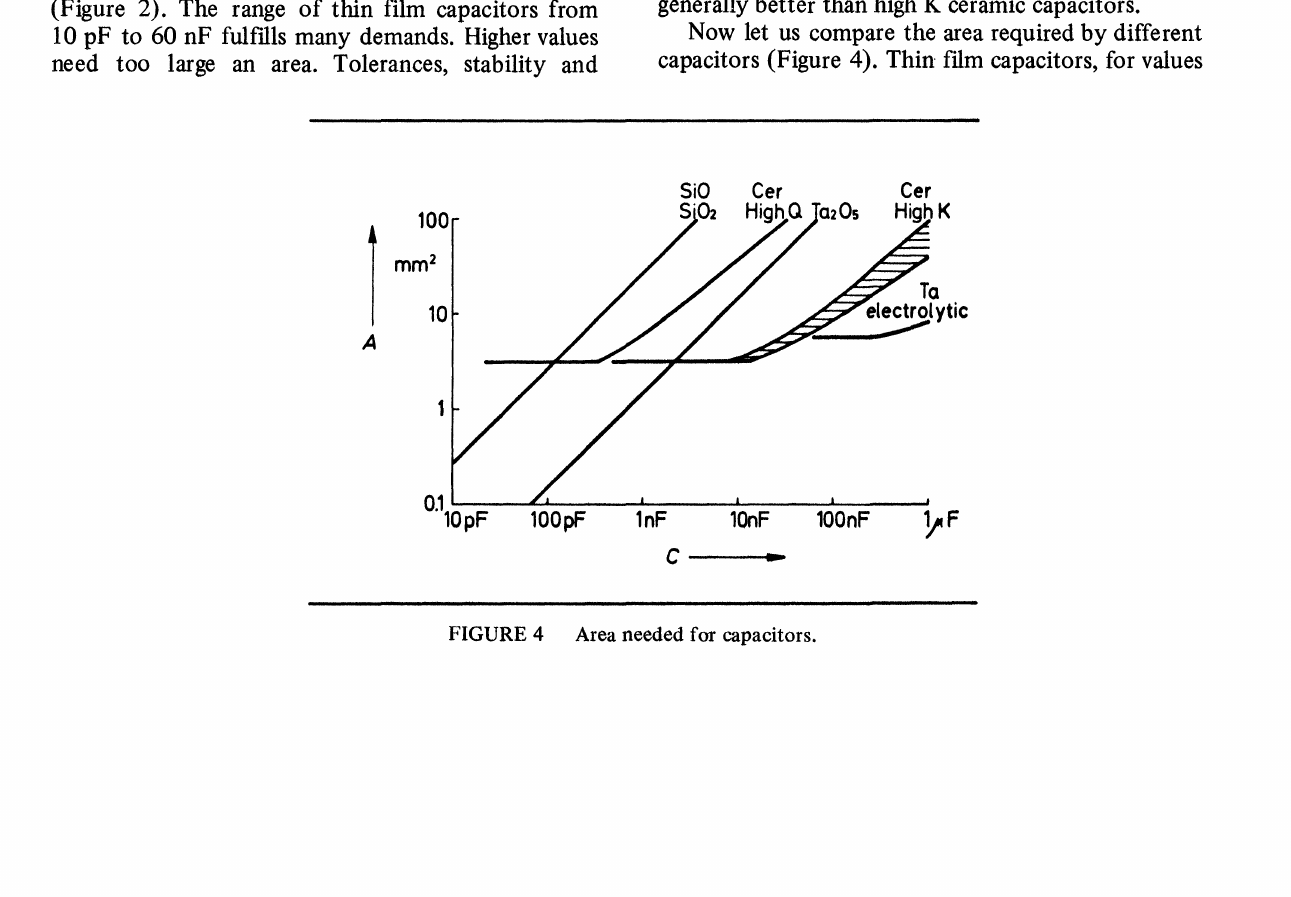
FIGURE 4 Area needed for